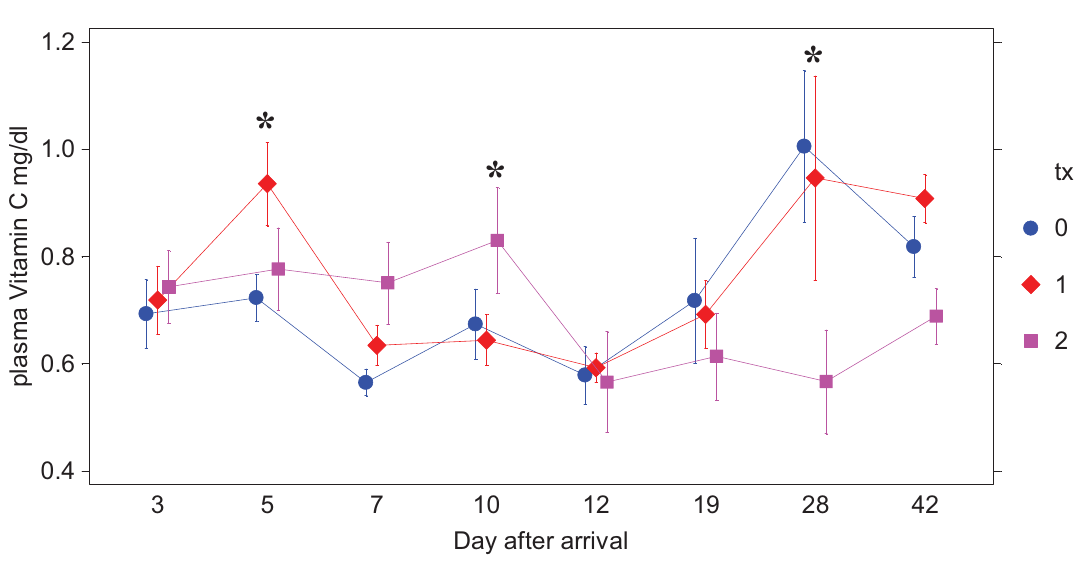
Figure 1. Plasma AA (mg/dL) by treatment group after arrival. Treatment 0 received only the carrier (unsupplemented applesauce), Treatment 1 supplementation of 5 g AA twice a day was stopped on day 5 post arrival and in Treatment 2 of 5 g AA twice a day was discontinued on day 10 after arrival. AA values are means ±